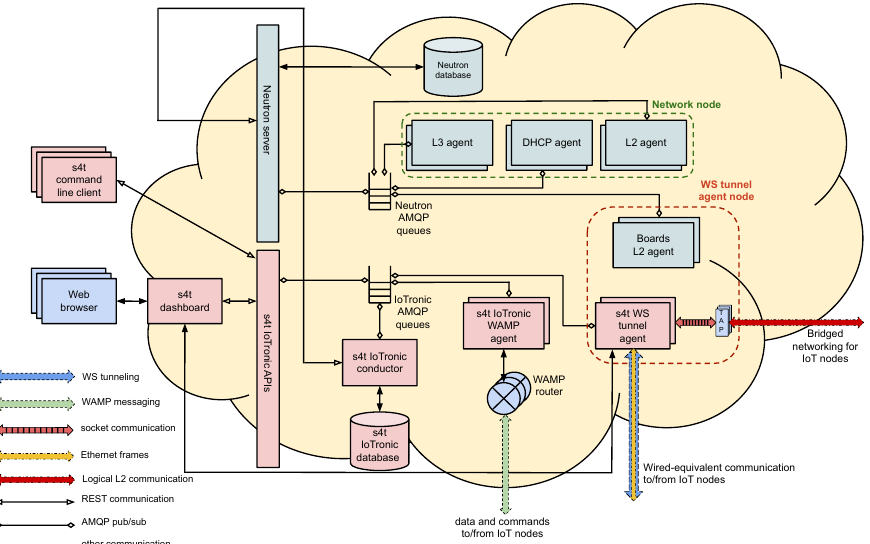
Figure 5. The cloud-side S4T virtual networking